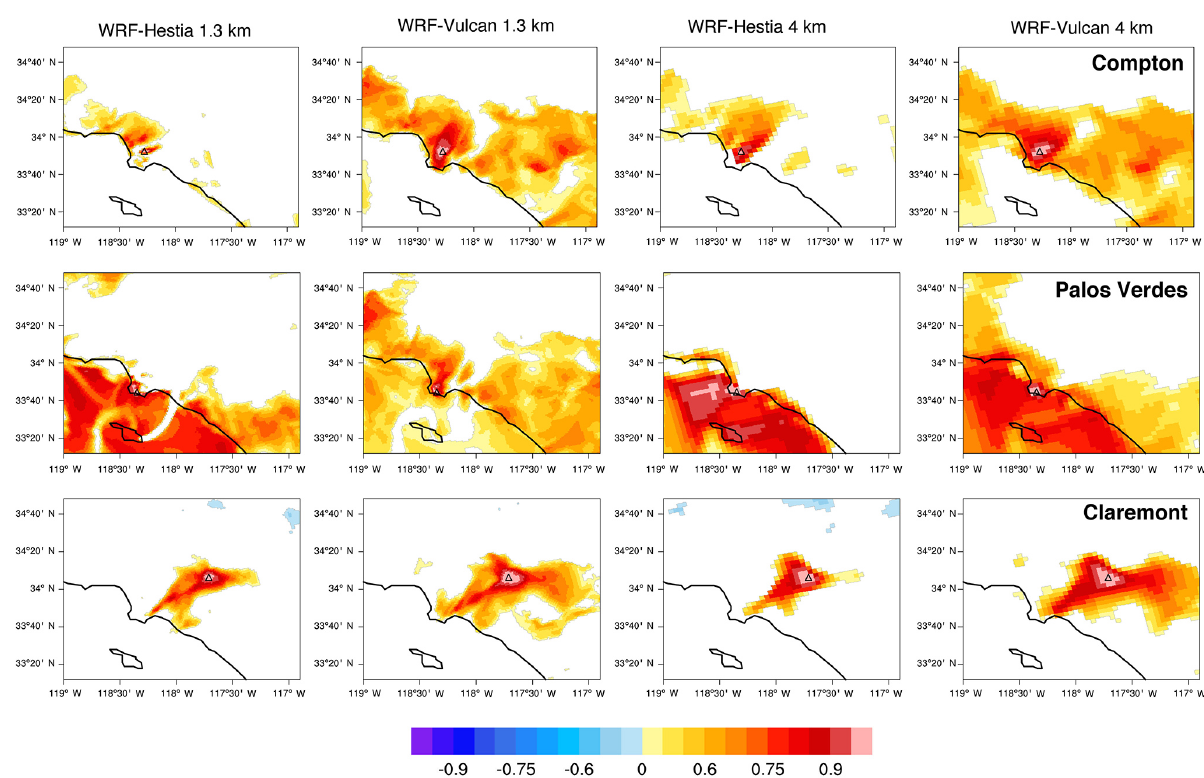
Figure 13. Same as Fig. 12 but for the Compton (top row), Palos Verdes (middle row), and CSUF (bottom row) sites only. Shown are the correlation maps of these three measurement sites for the 1.3km WRF-Hestia (first column), 1.3km WRF-Vulcan (second column), 4km WRF-Hestia (third column), and 4km WRF-Vulcan runs (fourth column). Note that only those pixels that pass the t test at the significance level of 0.01 ( | R | ≥ 0 . 46) are